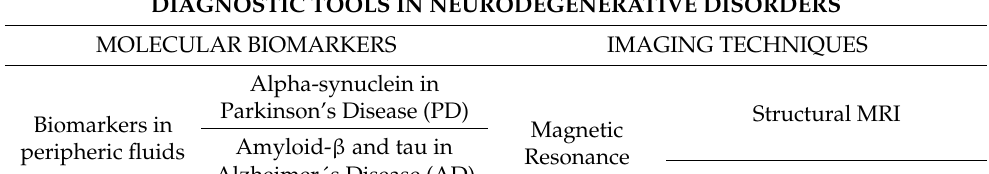
Table 2. Summary of the main molecular biomarkers and imaging techniques used in the diagnosis of Parkinson’s disease and Alzheimer’s